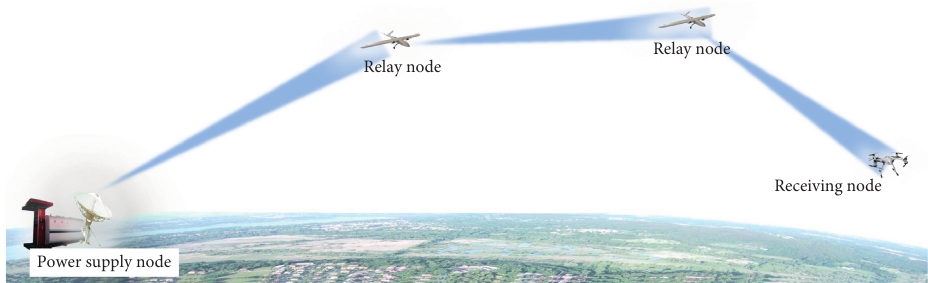
Figure 2: Schematic diagram of microwave wireless energy transmission link with multiple